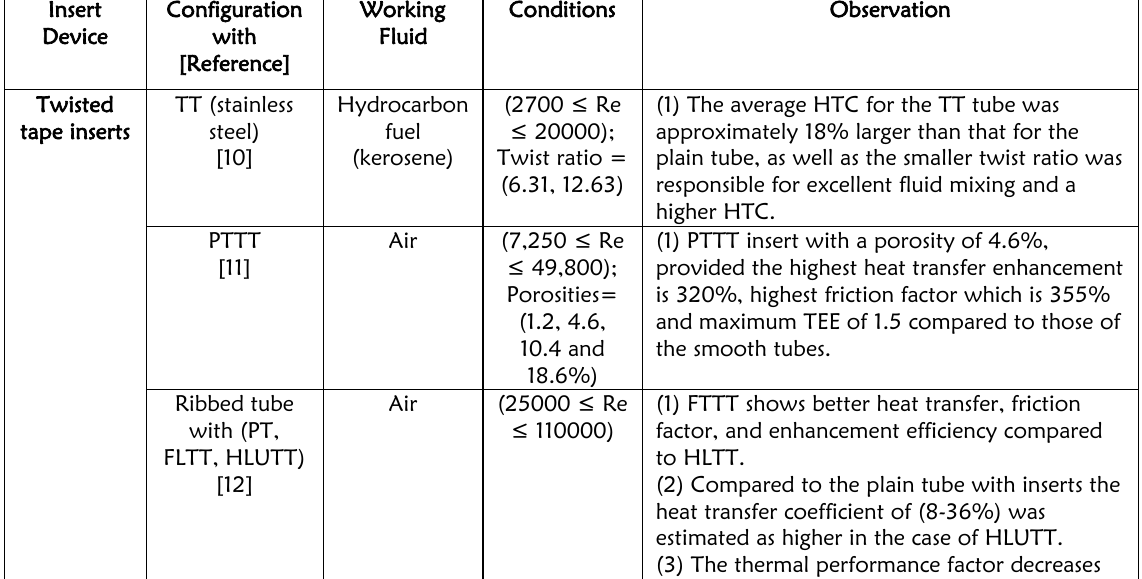
Table 2: Observation of recent investigations on various types of insert device in terms of heat transfer